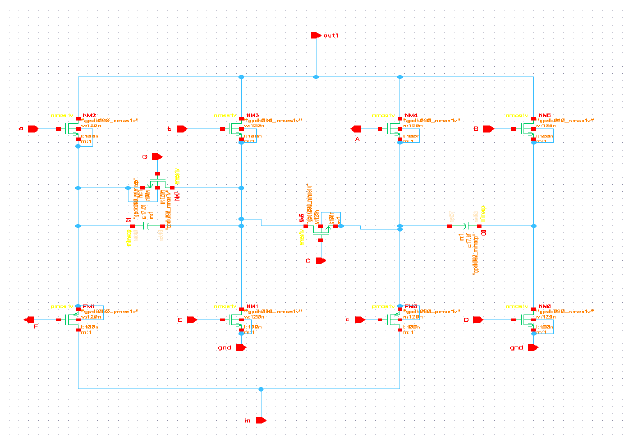
Figure 11. Schematic of existing switched capacitor converter